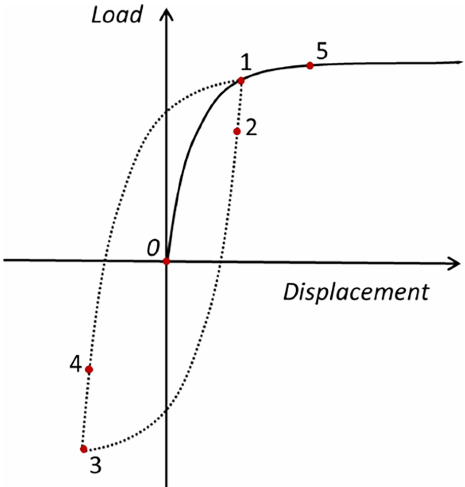
Figure 1. Observed foundation